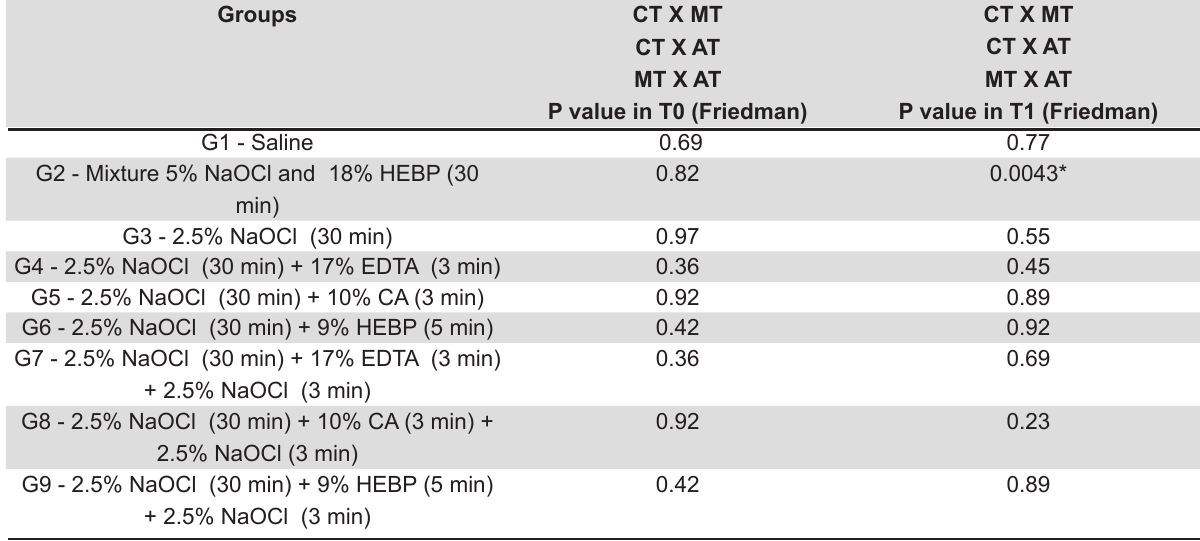
CT=cervical third; MT=middle third; AT=apical third; * P=0.0043: CT x MT P=not significant; CT x AT P<0.05; and MT x AT